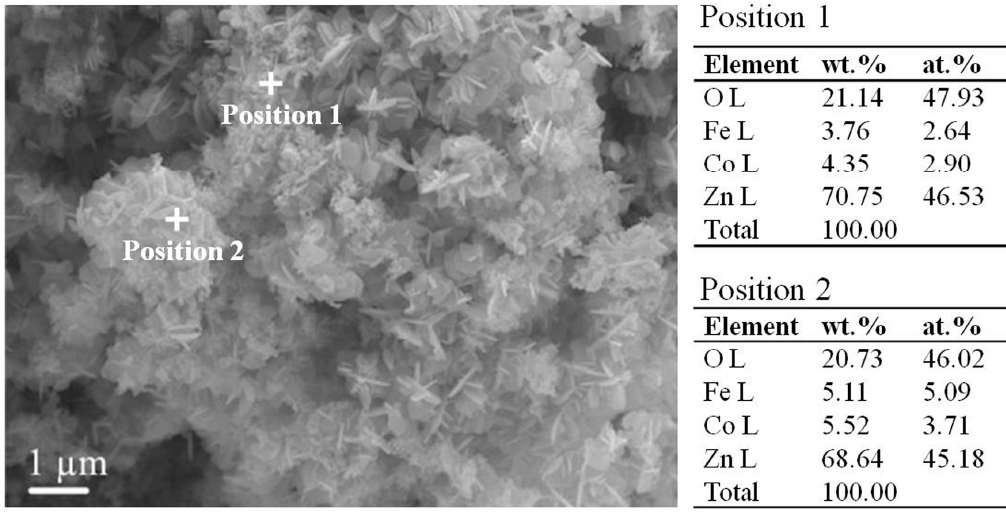
Figure 6. SEM and EDS of FeCo/ZnO composite.